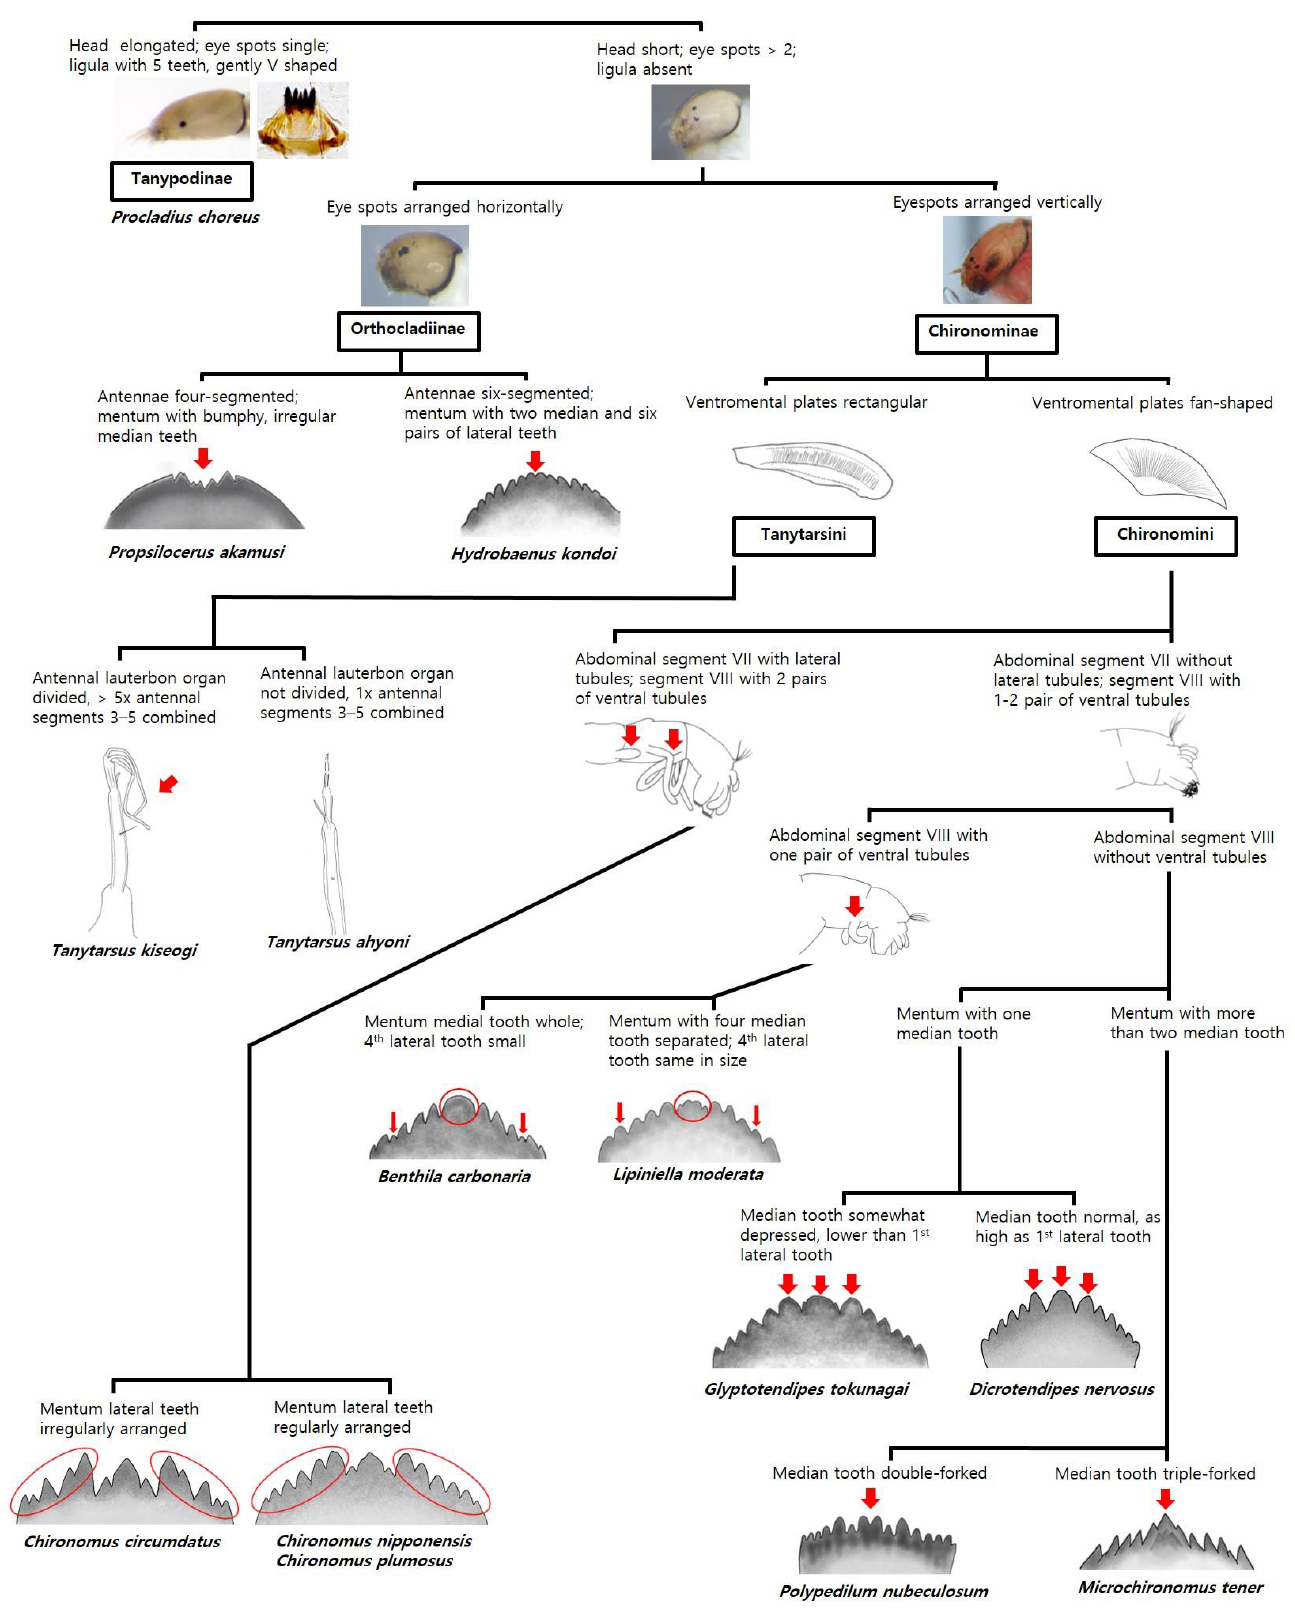
Figure 3. Pictorial key to chironomid larvae inhabiting large rivers in South Korea.